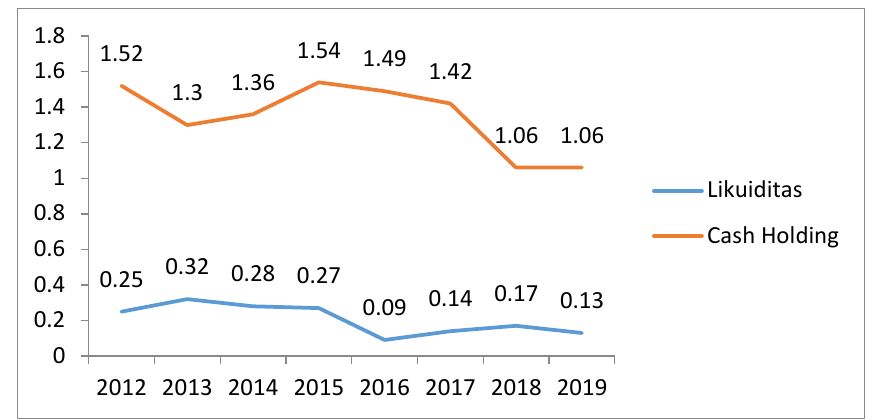
Figure 2. Diagram between Liquidity and Cash